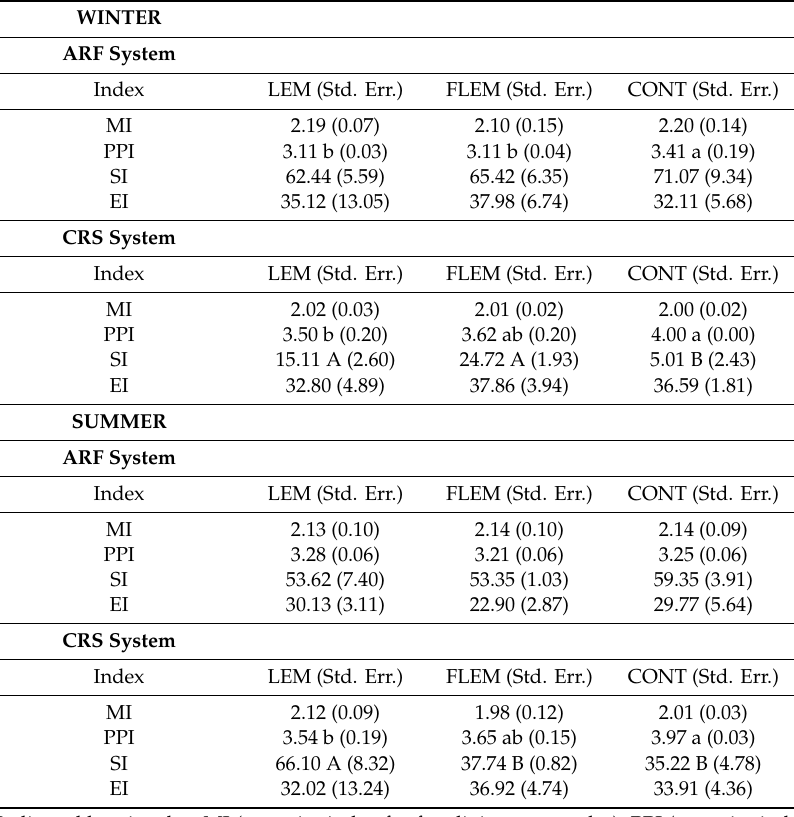
Table 3. Nematode index values from inoculant treatments (LEM, FLEM and CONT) by Season (winter / summer) and rotation system—Annual ryegrass / fallow system (ARF), and cereal rye / edamame soybean system